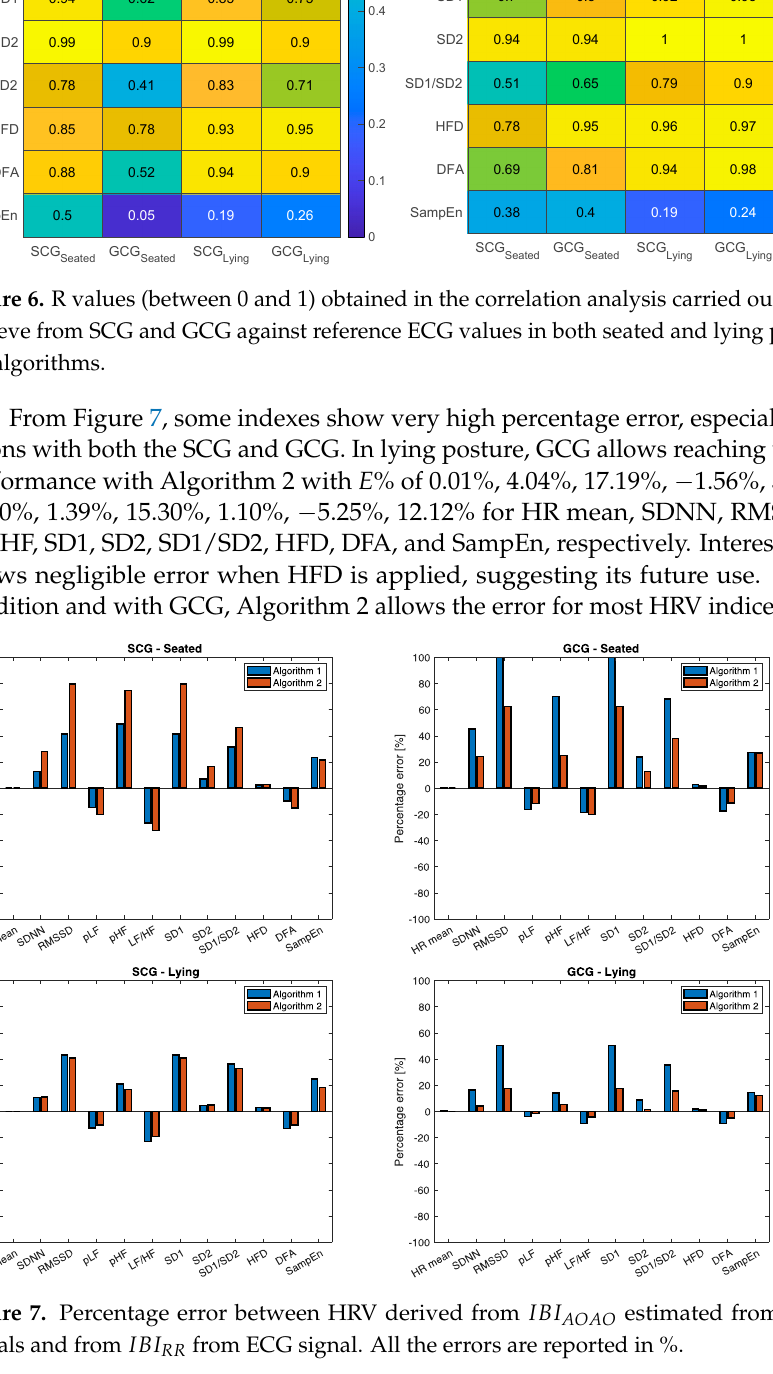
Figure 7. Percentage error between HRV derived from IBI AOAO estimated from SCG and GCG signals and from IBI RR from ECG signal. All the errors are reported in %.